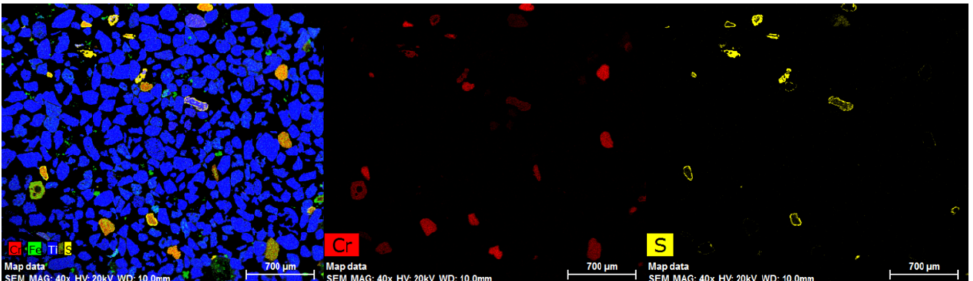
Figure 16. EDX mapping of sample DM‒2 (magnetic fraction) after magnetic separation at 0.7 A.